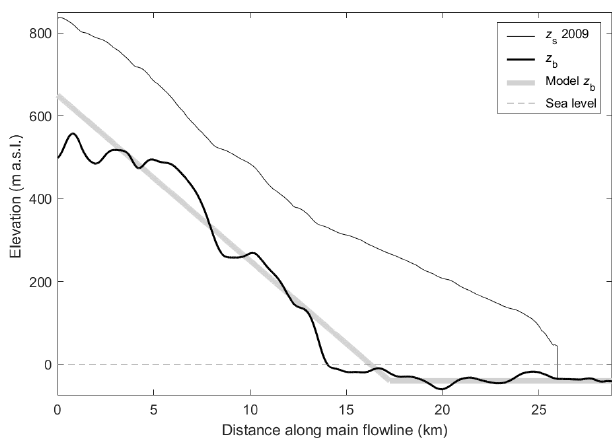
Figure 4. Cross-section along centreline profile (shown in Fig. 3) of the main flow band, with band averages of surface topography (thin black line) from the 2009/2011 NPI DEM and bed topography from the Fürst et al. (2018) reconstruction (0–12.5km), 2015 heli- copter radar measurements (12.5–25km), and hydrographic data in the fjord (Norwegian Mapping Authority Hydrographic Service). A piecewise linear profile is fit to the bed profile for the